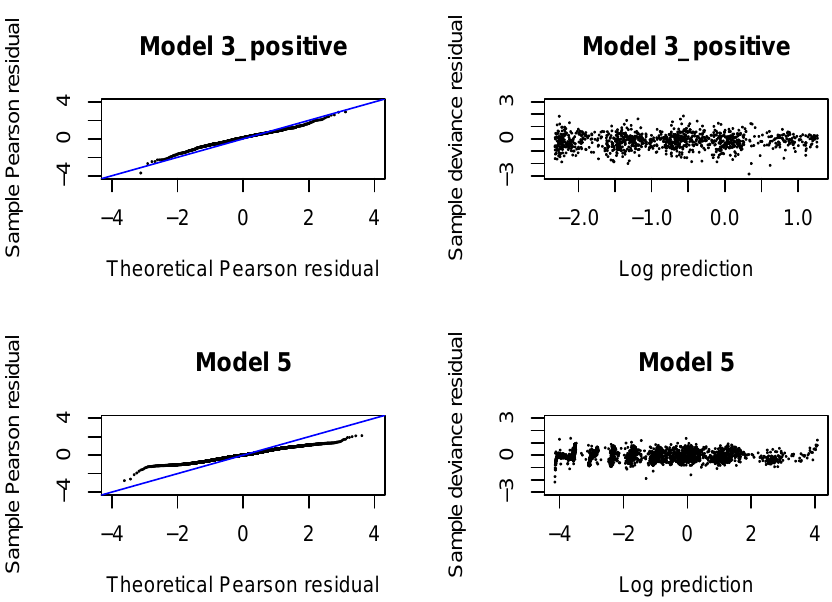
Figure A12. QQ normal plots and Tukey-Anscombe plots in Models 3_positive and 5 fitted with neural